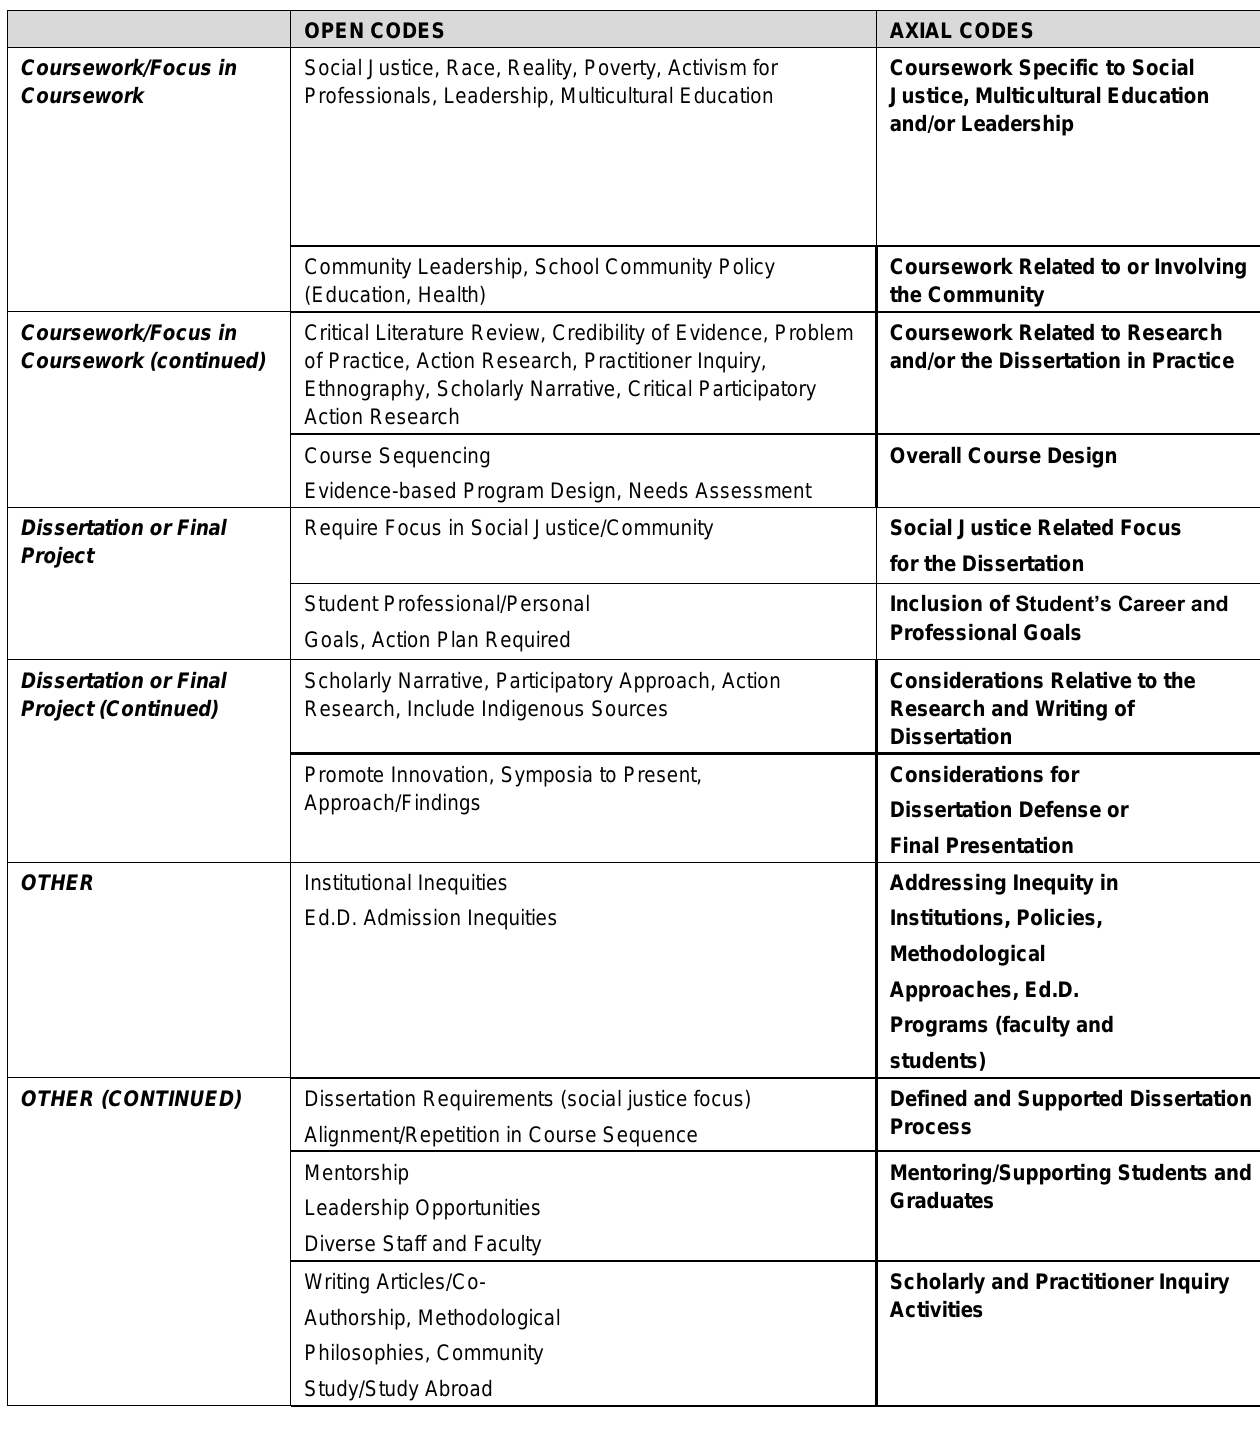
Table 2. Strategies to Facilitate/Support The Activist After the discussion related to the Profile of The Activist, facilitators asked small groups to discuss how Ed.D.